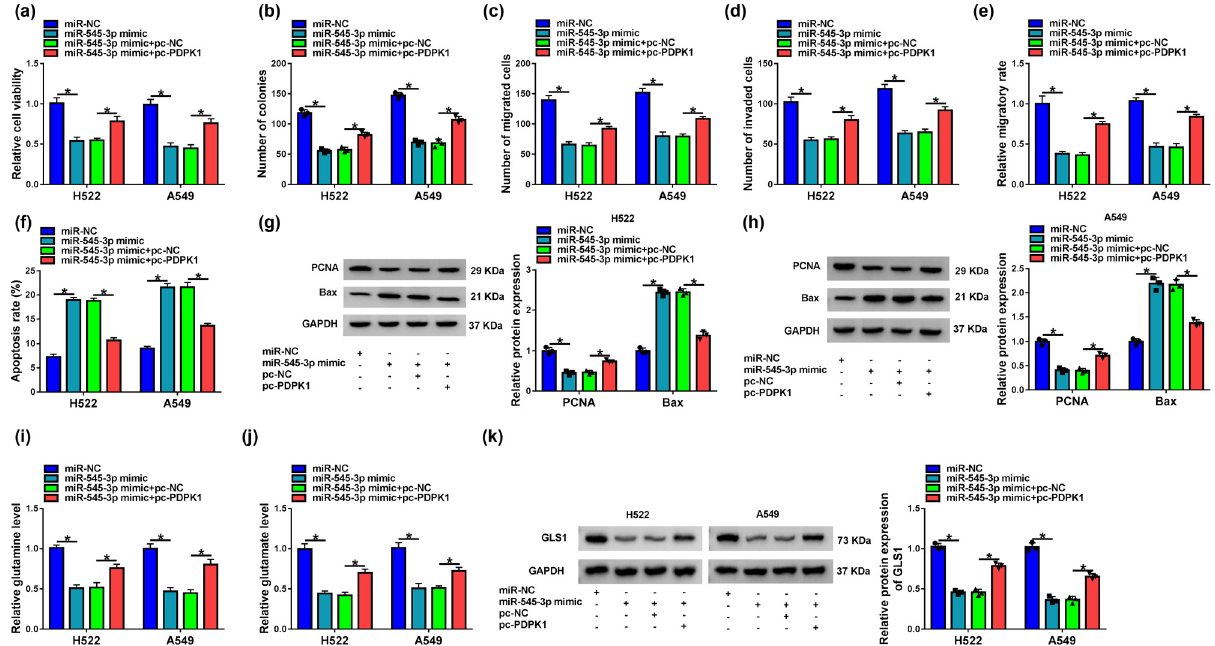
Figure 6: MiR - 545 - 3p mimic inhibited H522 and A549 cell tumor properties by associating with PDPK1. ( a – k ) MiR - NC, miR - 545 - 3p mimic, miR - 545 - 3p mimic + pc - NC, and miR - 545 - 3p mimic + pc - PDPK1 were transfected into H522 and A549 cells. ( a and b ) CCK - 8 and colony formation assays were employed to detect cell viability and colony - forming ability, respectively. ( c and e ) Transwell migration and wound - healing assays were carried out to evaluate the migratory ability of H522 and A549 cells. ( d ) Transwell invasion assay was conducted to determine the invasive ability of H522 and A549 cells. ( f ) Cell apoptosis was determined by fl ow cytometry analysis. ( g and h ) Protein expression of PCNA and Bax was determined by western blot analysis. ( i and j ) Levels of glutamine and glutamate were determined by glutamine determination and glutamate detection assays, respectively. ( k ) GLS1 protein expression was detected by western blot analysis. * P < 0.05.